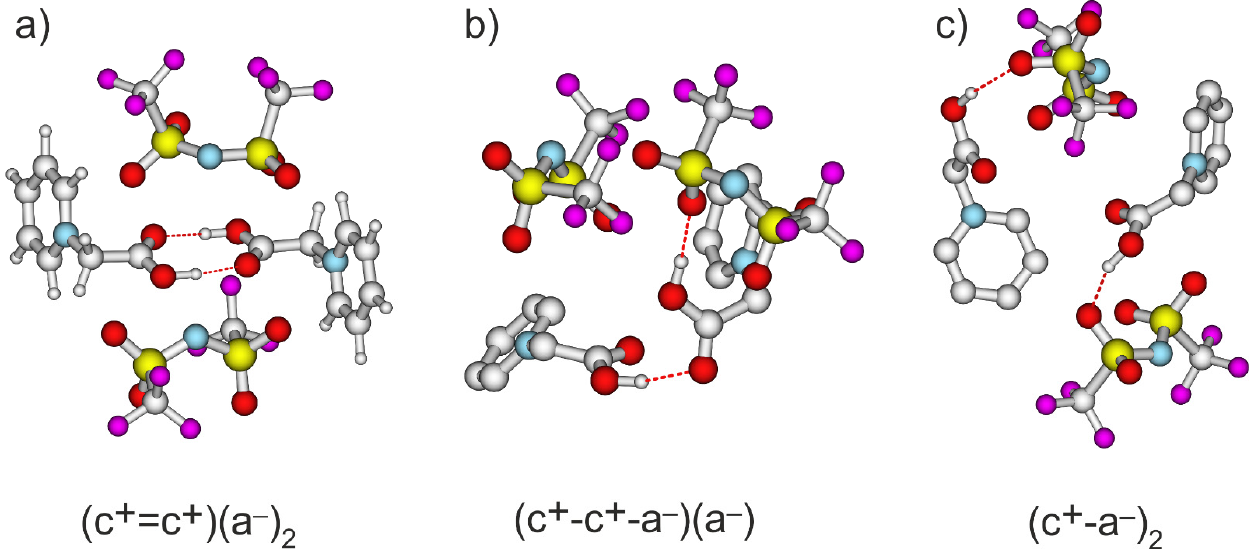
Figure 2. Structures of neutral complexes (HOOC–CH 2 –py + ) 2 (NTf 2 − ) 2 as calculated at the B3LYP– D3/6–31+G* level of theory. We considered three types of hydrogen bonding motifs (from left to right). ( a ) Two cations HOOC–CH 2 –py + are doubly hydrogen-bonded with each other, and two anions are attached to the cations without specific interaction, denoted as complex (c + =c + )(a − ) 2 . ( b ) In a (c + –c + –a − )(a − ) complex, the OH group on one cation HOOC–CH 2 –py + binds to the carboxyl group CO on the other, while the OH group of the other attaches an oxygen atom of the anion. (c) Both cations form single hydrogen bonds to one of the anions without any hydrogen bond formed among them, denoted as (c + –a − ) 2 .